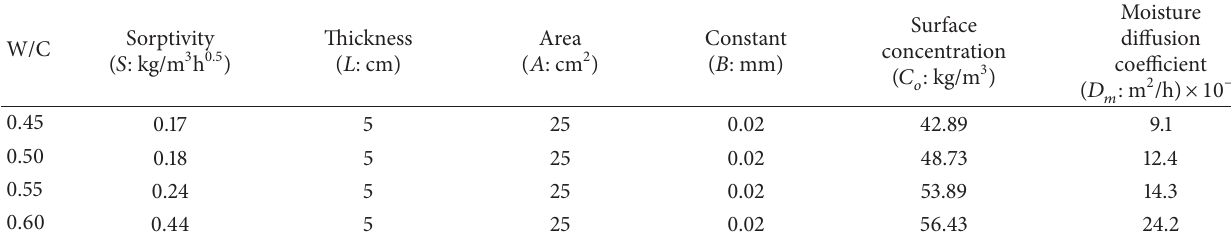
Table 5: Results of sorptivity, surface concentration, and moisture diffusion coefficient.